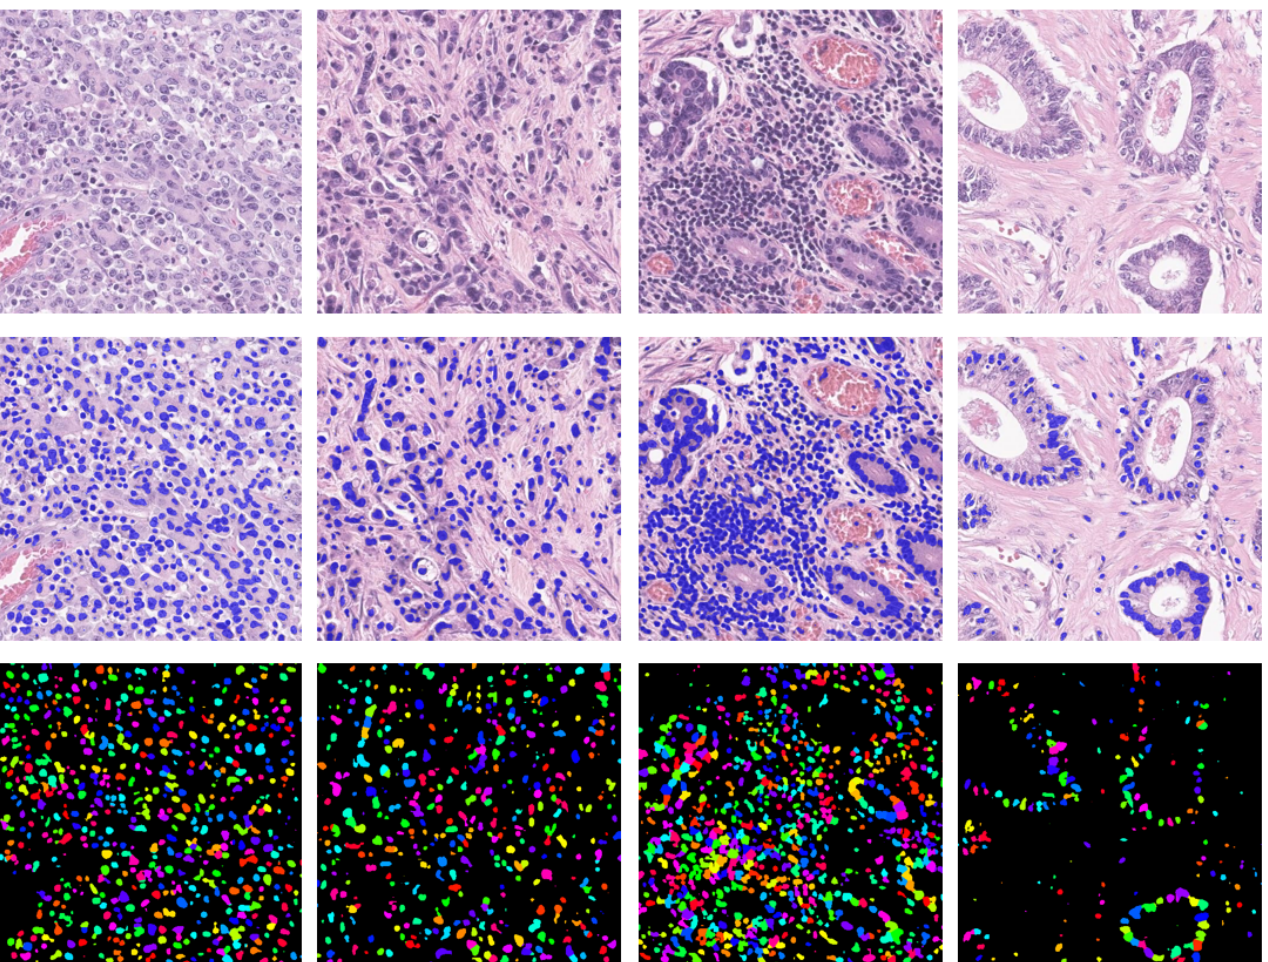
Figure 7. Examples of the NDG-CAM method on the data from the Pathology Department of IRCCS Istituto Tumori Giovanni Paolo II. Results are shown for the best architecture (DeepLab v3+ with ResNet18 backbone). ( First row ) Original images. ( Second row ) Semantic segmentation. ( Third row ) Instance segmentation after detection of centroids of the nuclei, with each color denoting a different nuclear